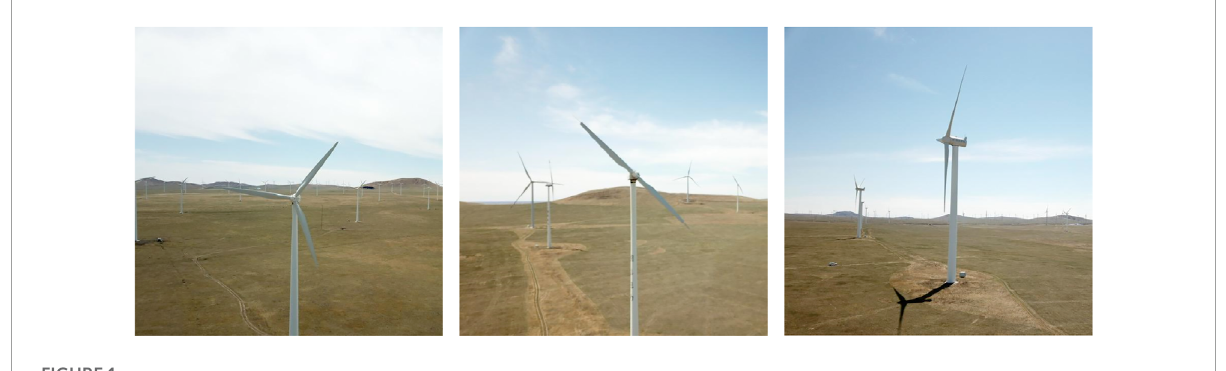
FIGURE 1 Examples of real wind turbine